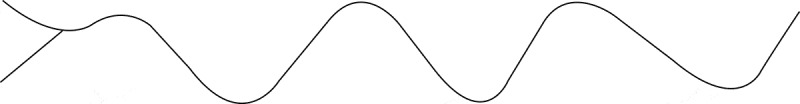
The schematic diagram of the recommended result.